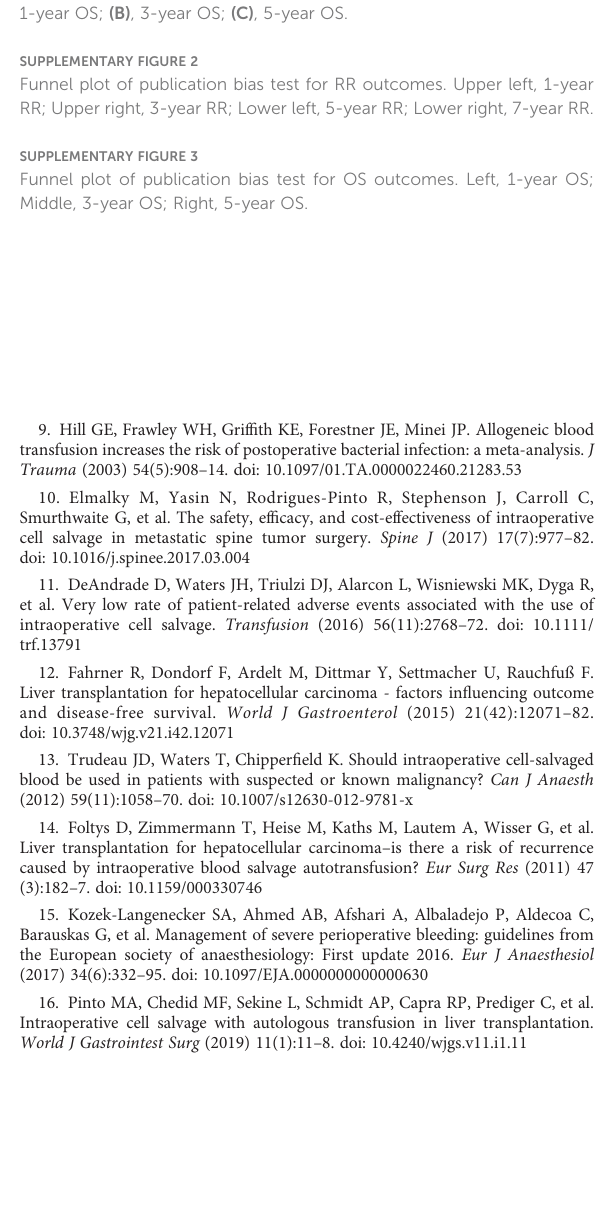
SUPPLEMENTARY FIGURE 1 Meta-analysisforestplotoftheoverallsurvivalaftersensitivityanalysis. (A) ,